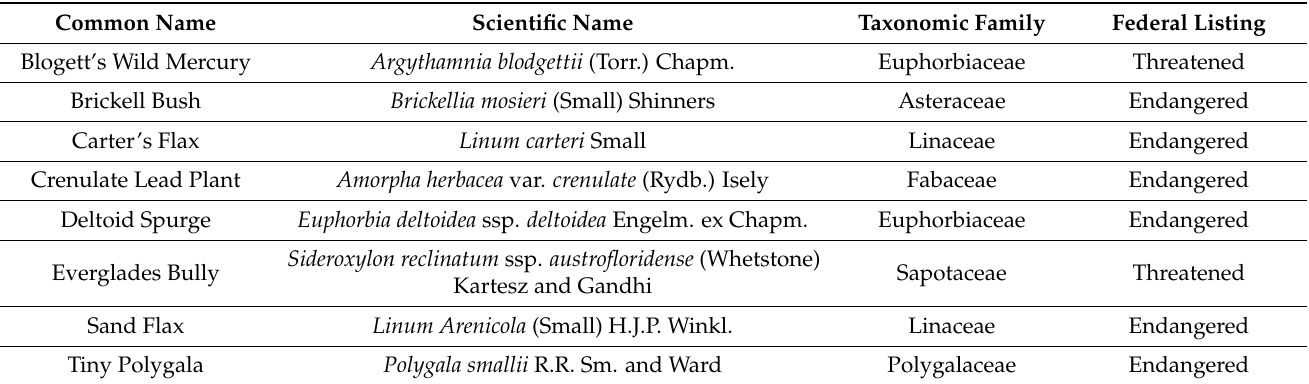
Table 2. List of eight federally listed plant species found in the Richmond pine rocklands (data from the Richmond Tract Management Plan; Possley et al. 2018).